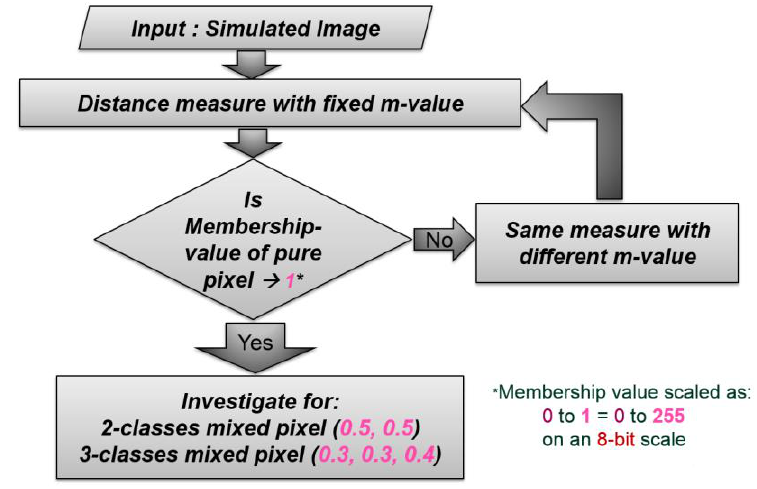
Figure 2. Flow chart for optimizing the parameter.